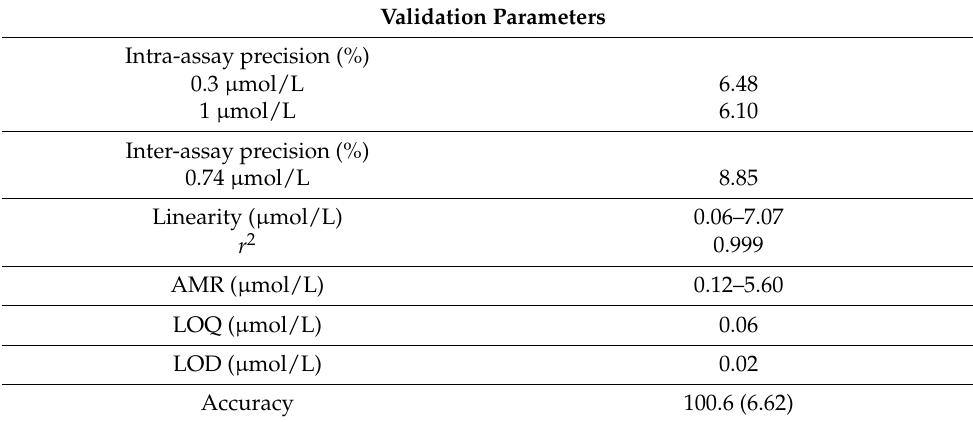
Table 1. Validation parameters of the new HPLC-ED method for CoQ analysis. Accuracy is expressed as % recovery, and its standard deviation is indicated in brackets. Abbreviations: AMR, analytical measurement range; LOQ, limit of quantification; LOD, limit of detection.